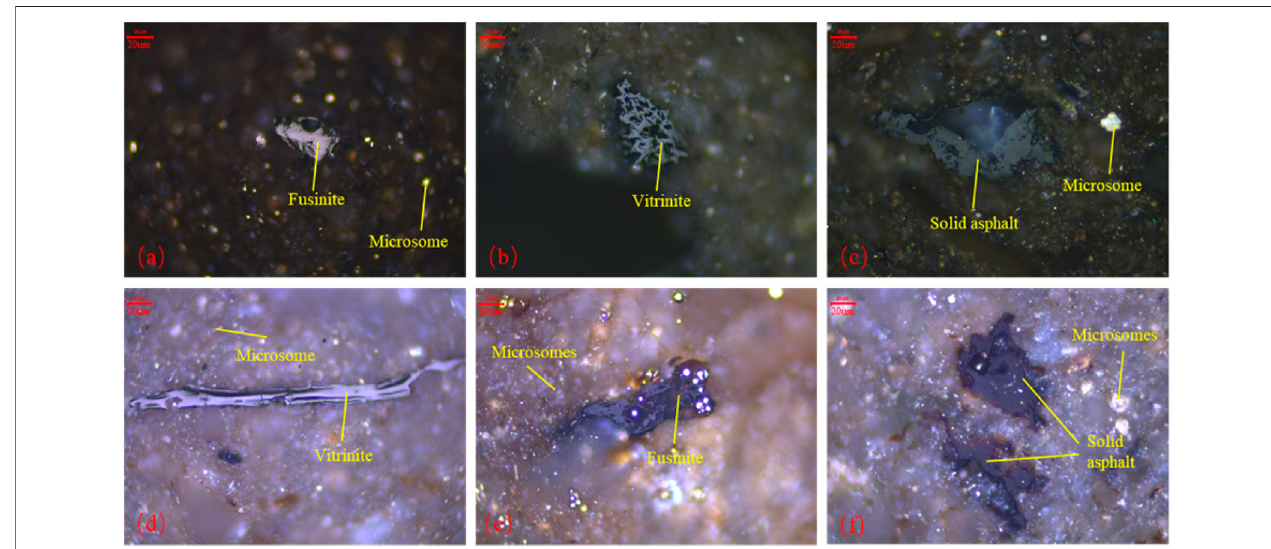
FIGURE 4 | Organic macerals characteristics of the typical shale samples under the microscope. (A) Fusinite, well Y1, 3,885 m. (B) Vitrinite, well Y1, 3,907.44 m. (C) Solid asphalt, well Y1, 3,915.82 m. (D) Vitrinite, well T1, 43.91 m. (E) Fusinite, well T1, 53.88 m. (F) Solid asphalt, well T1, 28.2 m.